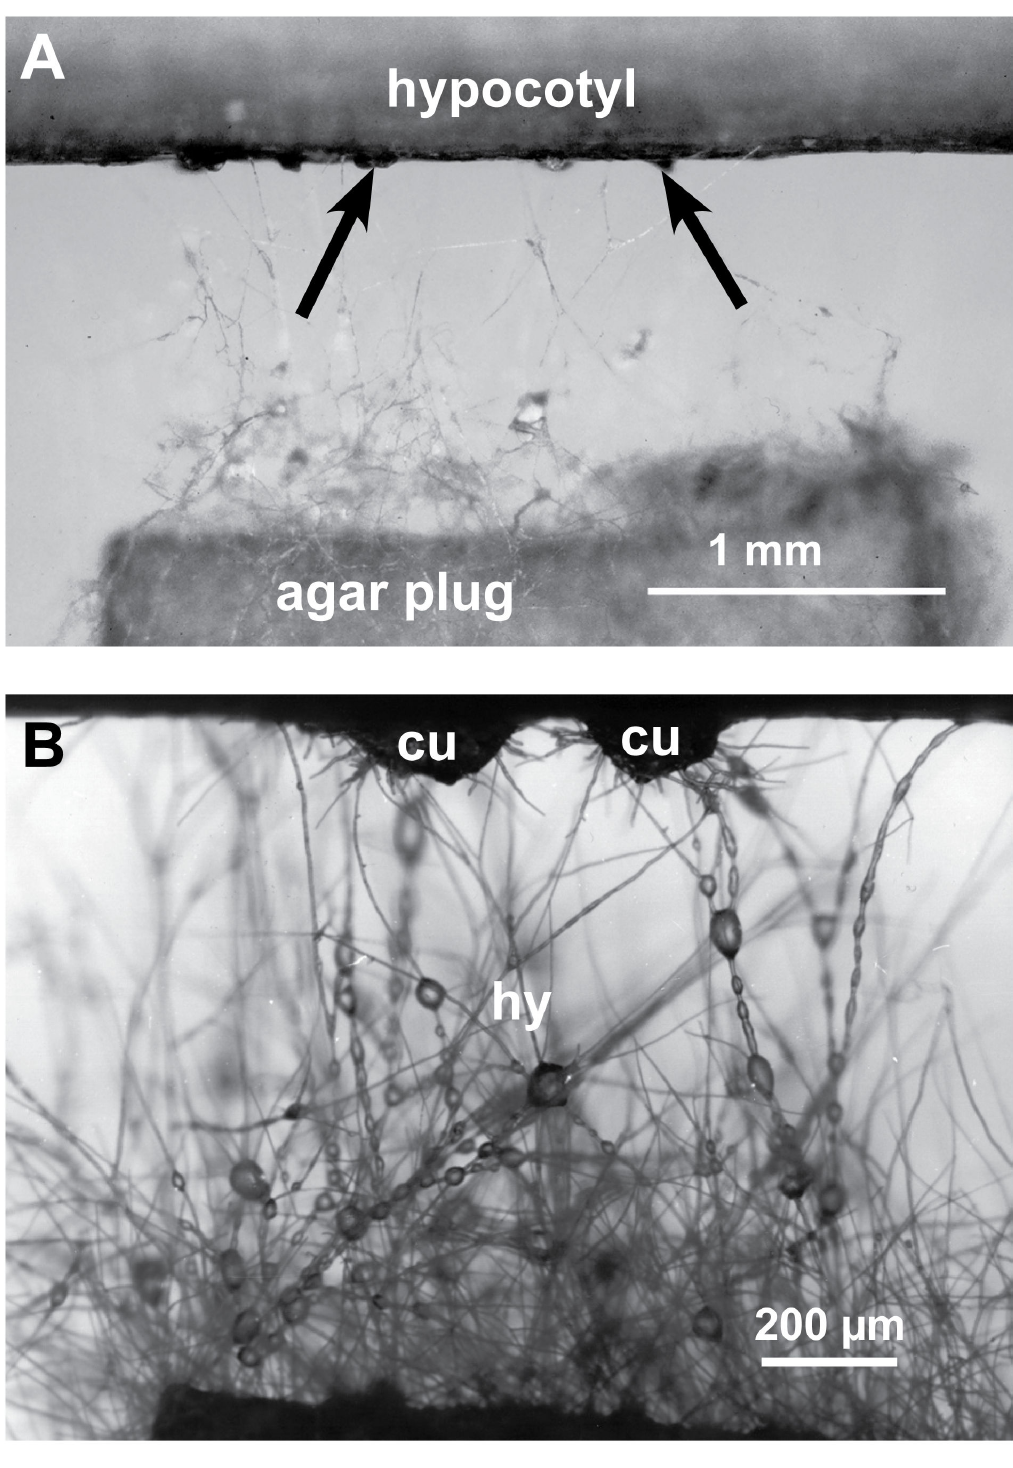
Figure 1. Inoculation method for following the early infection process. A piece of sunflower hypocotyl and an agar plug with actively growing mycelium of S. sclerotiorum were placed at a distance of about 1 mm in a Petri dish with wet filter paper. A : Aerial mycelium developed and when prospecting hyphae came in contact with the host surface dome-shaped infection cushions (arrows) developed at 12–24 hpi. B : Detail of Figure 1A; prospecting hyphae (hy) of the aerial mycelium with water droplets and two infection cushions (cu). doi: 10.1371/journal.pone.0072292.g001 PLOS ONE |